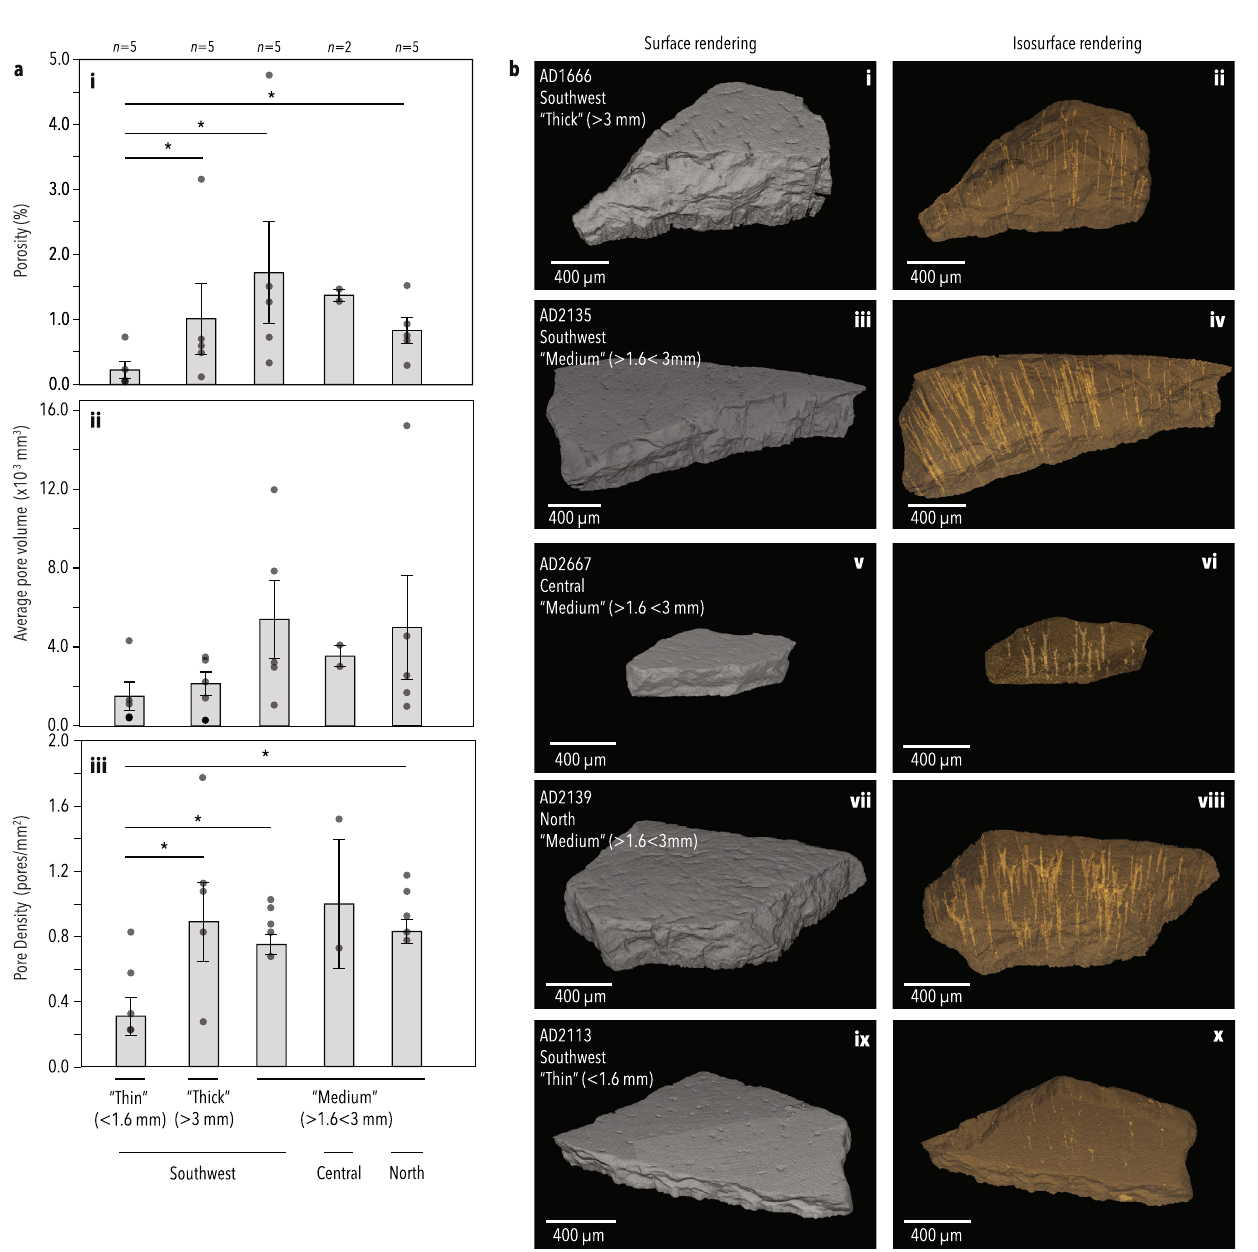
Fig. 3 | Micro-CT characterisation of eggshell morphotypes. a Bar chart com- paring the mean porosity, mean ‘ average volume per pore ’ (proportional to pore area), and mean pore density within the ROI examined of each eggshell morpho- type. Error bars represent 95% con fi dence intervals of the standard error. Sig- ni fi cant differences ( p <0.013, two-sided Mann – Whitney U test with Bonferroni